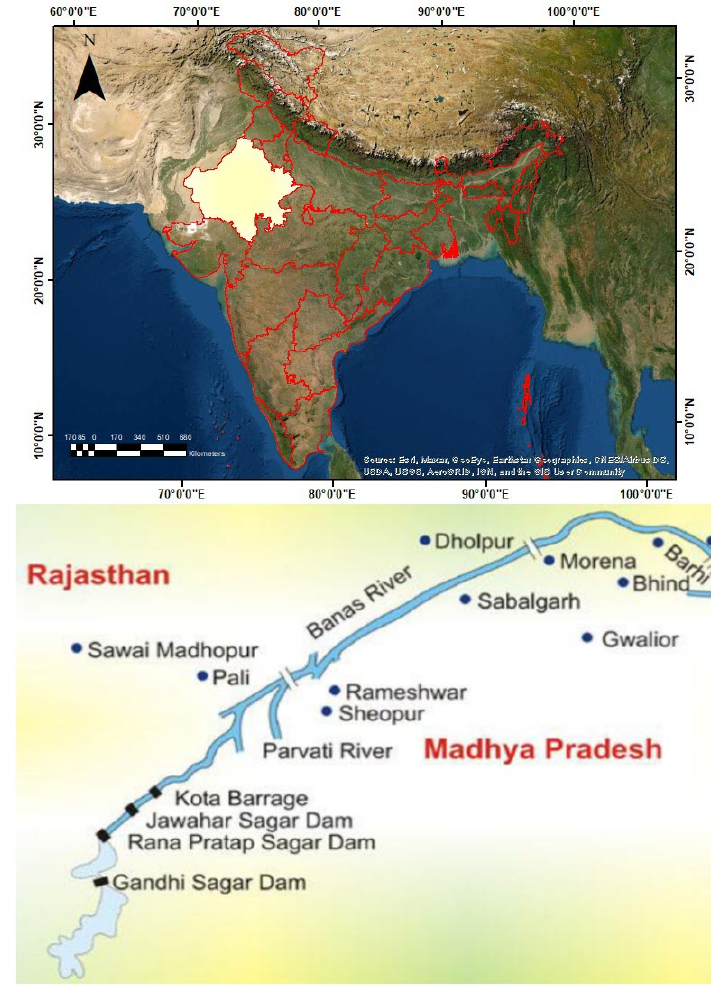
Figure 1. Study area map of Chambal River.